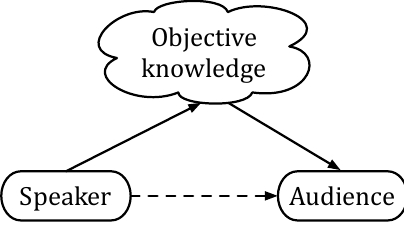
Figure 3 . Speaker vs. objective knowledge vs. audience The dashed line here shows that the link between the speaker and the audience is only an indirect